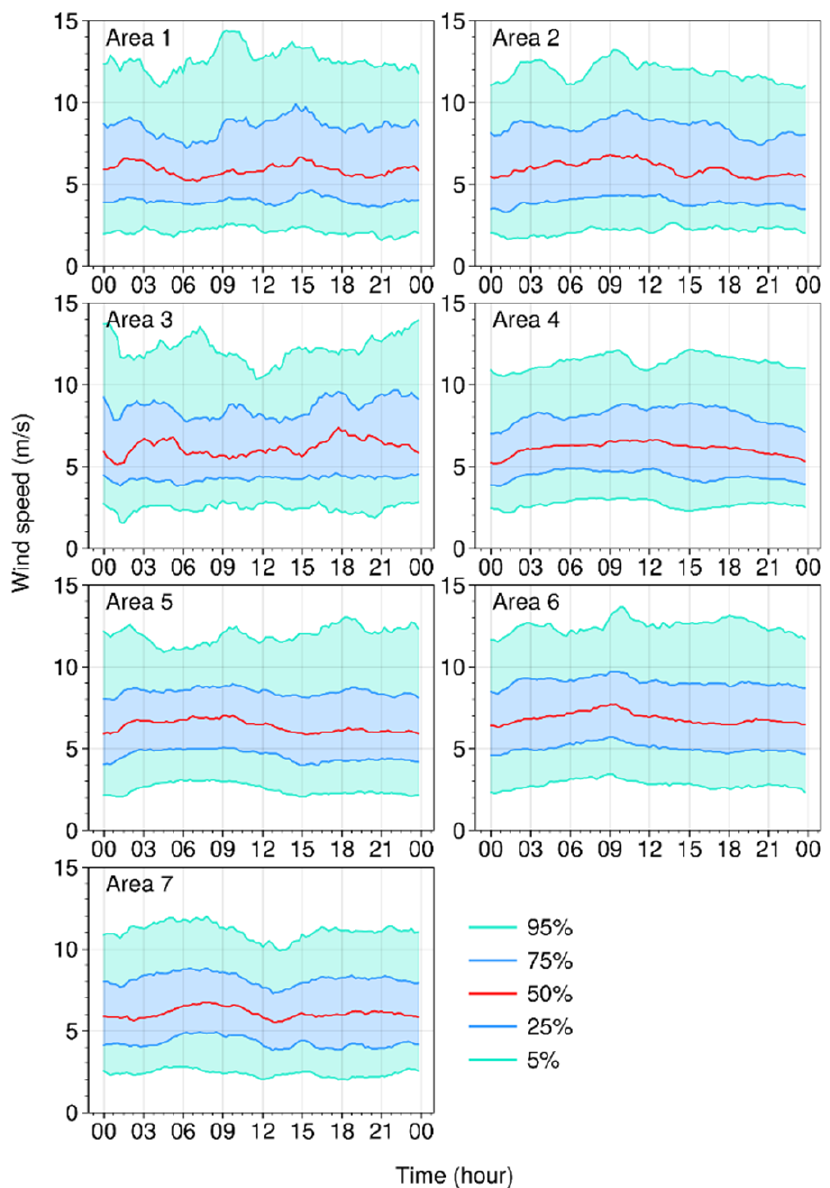
Figure 2. Diurnal variation in the observed wind speeds for the seven sub-areas. The red line is the median value, dark blue is 25–75%, and the light blue zone (including dark blue zone) is 5–95%. The x-axis represents the time